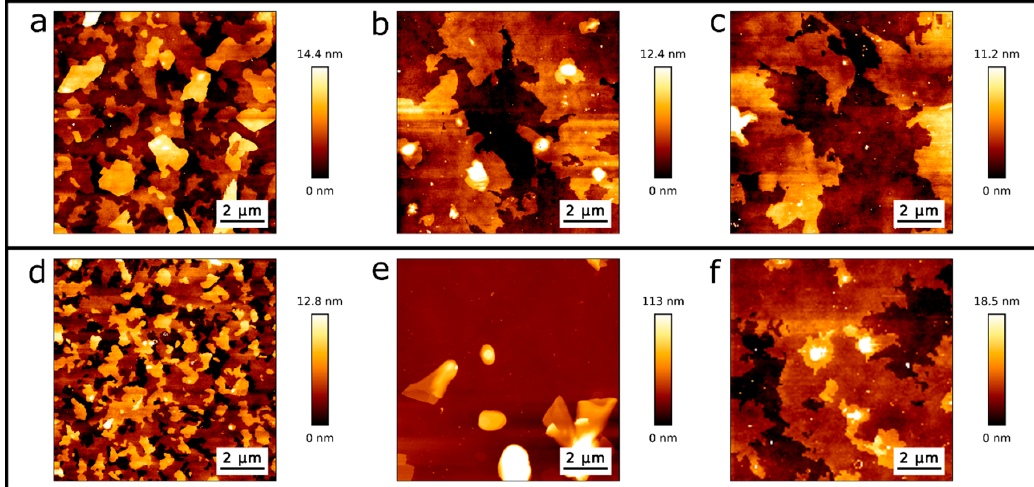
Figure 5. Topographic AFM images from DPPC/SiO 2 /Si samples at RT: ( a ) directly after evaporation and before the first temperature cycle, ( b ) after the first and ( c ) sixth temperature cycle performed within the ellipsometer. ( d ) Topography image directly after evaporation and before temperature cycling within the AFM, ( e ) after the first temperature cycle while scanning with AFM, and ( f ) after the first temperature cycle in a contiguous region to the scanned area.